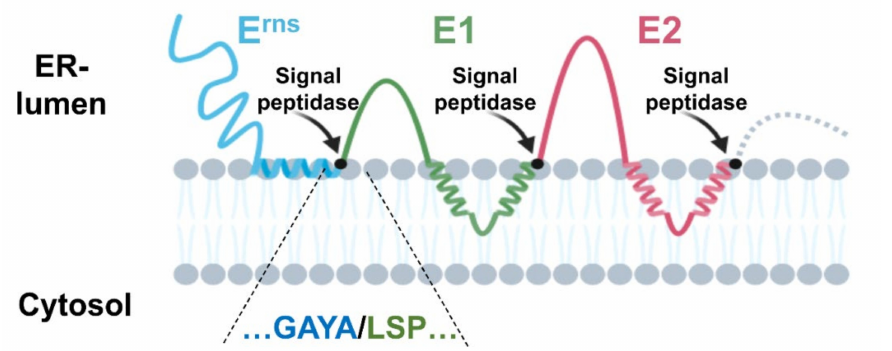
Figure 2. Processing of the pestivirus glycoprotein precursor. Schematic representation of the precursor with the three pestiviral glycoproteins in their precleavage topology (further details in [57]). The SP cleavage sites are indicated by black dots. For the E rns /E1 site, the flanking sequences are given below the scheme using the colors of the protein representations. The amino acid sequence is derived from CSFV